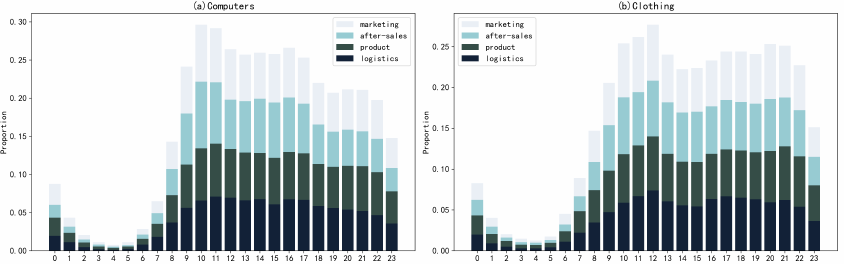
Figure A4. Proportions of main reasons for negative reviews on an hourly scale. ( a ) is the stacked histogram for the sector Computers and ( b ) is for Clothing. The x -axis is hours, from 0 to 23, and the y -axis is the proportion of a certain reason at the corresponding hour.